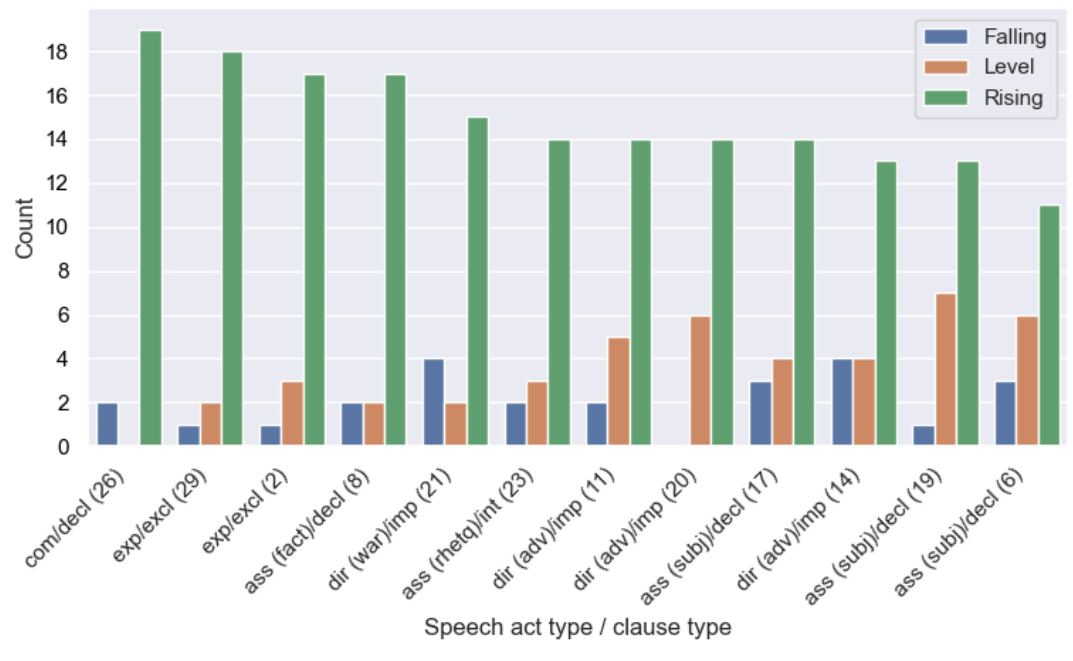
Figure 7. Contour types according to speech act types